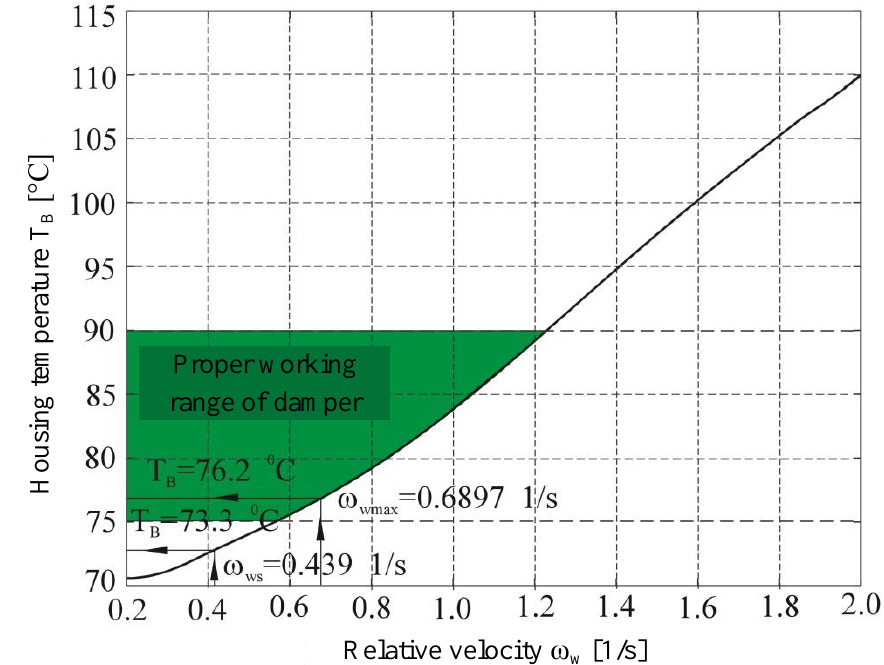
Figure 14. Calculated rate and experimental data for working temperature of a viscous torsional vibration damper T B as a function of the relative velocity of the inertia ring; ω ws —measured average relative velocity of the inertia ring, ω wmax —measured maximum relative velocity of the inertia ring.